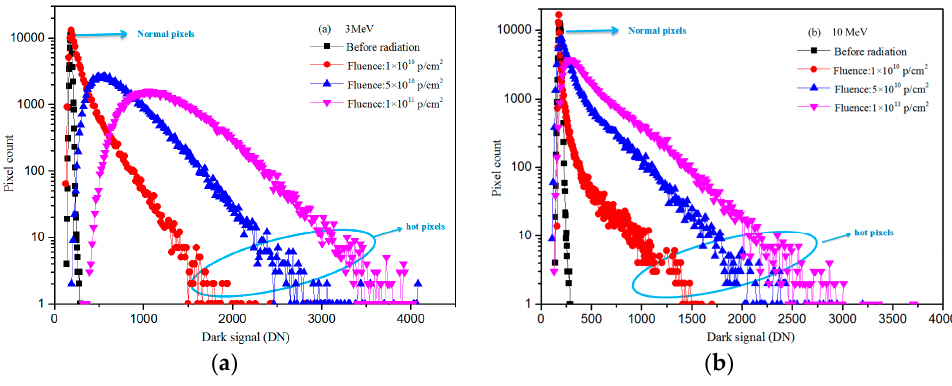
Figure 6. Dark signal distributions of CISs after proton irradiation: ( a ) proton energy: 3 MeV; and ( b ) proton energy: 10 MeV.